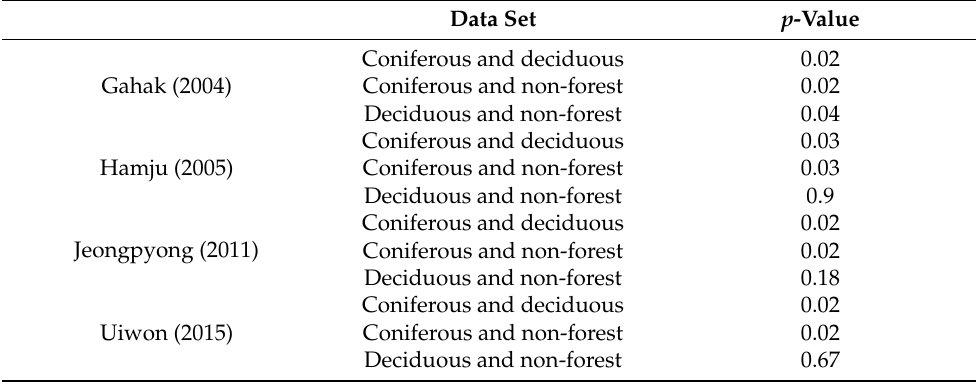
Figure 10. Areas of forest types burnt by fires in the study area. ( a ) GWP; ( b ) SHP. To estimate the forest type with regard to burn severity, a forest map was derived from overlaid Landsat images and a burn severity map. It was investigated using five burn severity categories in four large fire-burned areas except for the “unburned burn severity level” because there was no damage in the forest. Overall results show differences in burn severity levels between coniferous and deciduous and coniferous and non-forest in large fires in GWP and SHP. While there was a difference in burn severity level between deciduous and non-forest in large fires in GWP, there was no difference between deciduous and non-forest in large fires in SHP. The non-forest area was greater in SHP than in GWP. To investigate the difference in burn severity level between coniferous, deciduous, and non-forest areas in the four studied large fire-burned areas, the Wilcoxon paired test with a 5% significance level was used in this study. Table 4 shows differences in burn severity levels between coniferous and deciduous and between coniferous and non-forest in large fires in GWP and SHP. However, there was no difference in burn severity level between deciduous and non-forest in large fires in SHP. Non-forest area in SHP was more susceptible to large fire damage than in GWP. Table 4. Wilcoxon test results for burned